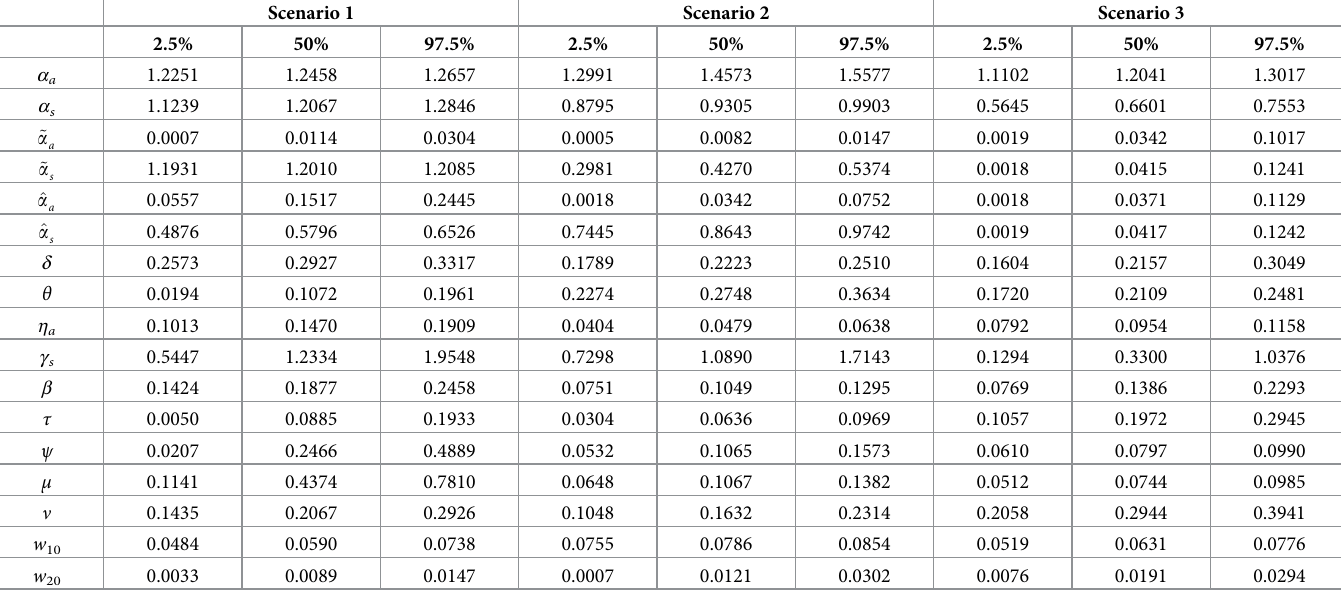
Table 4. Median and 95% quantile-based intervals for parameters in System